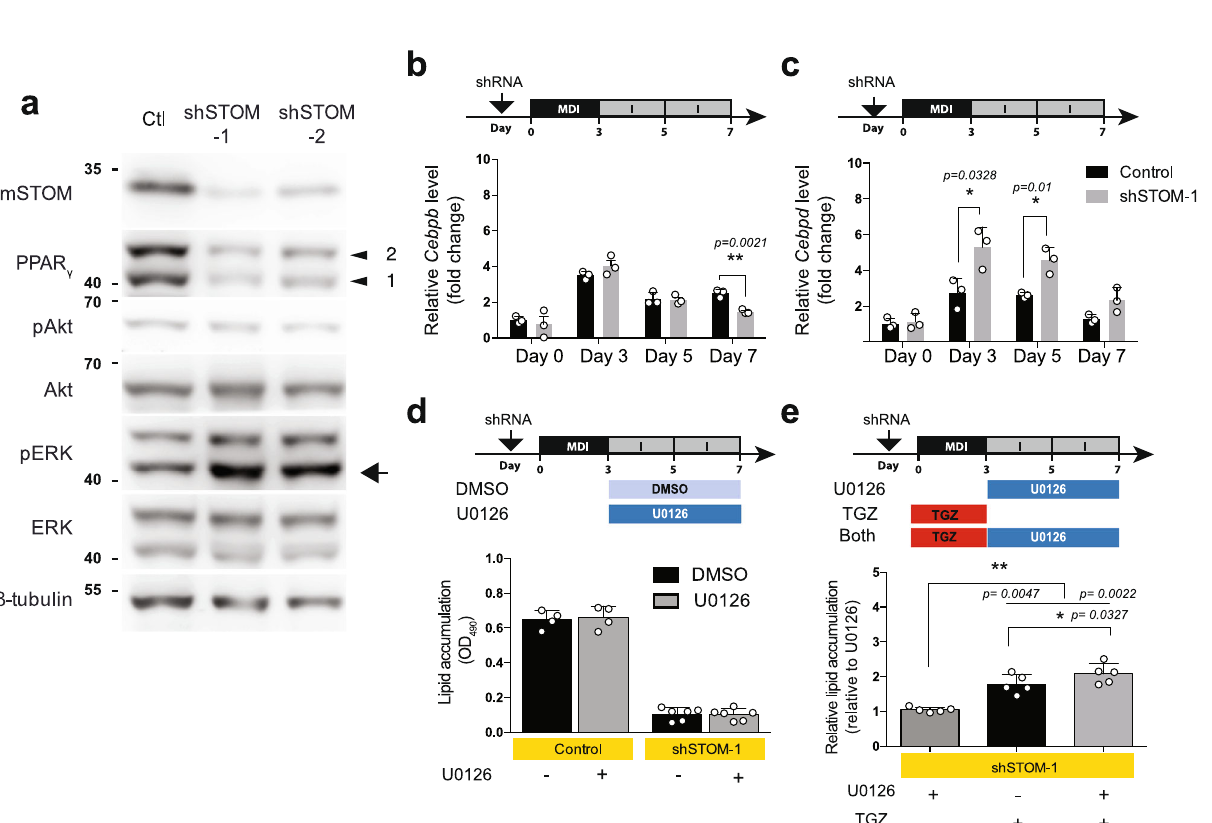
Fig. 7 Knockdown of stomatin activated ERK-pathway. a shRNA was transduced into 3T3-L1 cells to knockdown stomatin, generating shSTOM-1 and shSTOM-2 cells. After induction of differentiation, Western blotting analyses showed that although Akt pathway remained unchanged, the ERK pathway was activated, as evidenced by increased pERK (arrow). b , c Expressions of early adipogenic genes, Cebpb and Cebpd , were examined at the mRNA level by qPCR. b Expressions of Cebpb increased in the fi rst three days of adipogenic differentiation, and subsequently decreased. Knockdown of stomatin (exempli fi ed by shSTOM-1 cells) did not signi fi cantly in fl uence this pattern. c Expressions of Cebpd gene also exhibited a transient early increase then declined; however, knockdown of stomatin appeared to signi fi cantly increase and maintain Cebpd expression at a relatively higher level than the control. b , c The house-keeping Nono gene was used as the reference for qPCR experiments. * P < 0.05, and ** P < 0.01 by multiple unpaired t -test. d Levels of lipid accumulation by adipocyte-like 3T3-L1 cells were quanti fi ed by measuring OD 490 after Oil Red O staining. Treating shSTOM-1 cells with 10 µ M U0126, an ERK pathway inhibitor, from Day 3 to Day 7, did not reverse the inhibition of lipid accumulation caused by stomatin knockdown. Mean± s.d. for n = 4 (Control) and n = 6 (shSTOM-1) independent experiments. e On the other hand, treating shSTOM-1cells with TGZ, a PPAR γ activator, in the fi rst three days of adipogenic differentiation, was able to partially recover the knockdown-caused lipid accumulation de fi cit; treating shSTOM-1cells with both TGZ and U0126 could further increase lipid accumulation. Mean ± s.d. for fi ve independent experiments. * P < 0.05, and ** P < 0.01 by one-way ANOVA. Source data are provided as a Source data fi (Supplementary Fig. 8d). Histological analyses only revealed with the body weights of Stom + / − mice. The body weight slightly smaller adipocytes in fat pads of Stom − / − mice compared increments were not signi fi cantly different comparing Stom − / − with Stom + / − mice fed with either CD or HFD (Supplementary to Stom + / − littermates (Supplementary Fig. 8e). Expressions of Fig. 8c). The mass of SAT, VAT and BAT were also similar adipogenic genes in HFD-fed Stom − / − mice also resembled those